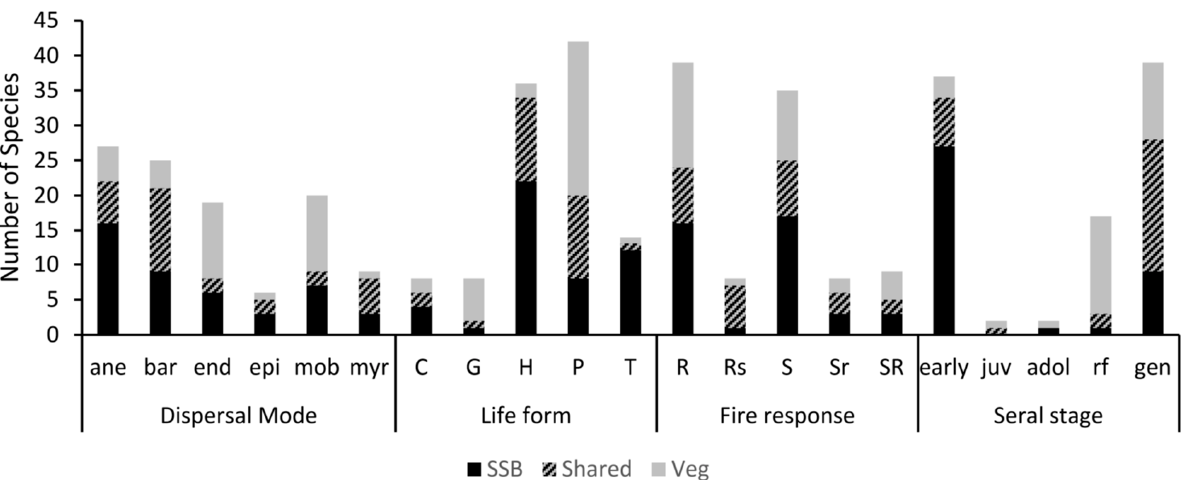
Figure 3. Frequency of plant functional types restricted to the soil seed bank (SSB) or extant vegetation (Veg), and those shared between vegetation pools. Dispersal mode: ane, anemochory; bar, barochory; end, endozoochory; epi, epizoochory; mob, mobile; myr, myrmecochory. Life form: T, therophyte; H, hemicryptophyte; C, chamaephyte; P, phanerophyte; G, geophyte. Fire response: R, obligate resprouters; Rs, weak resprouters; S, obligate seeders; SR, facultative seeders; Sr, weak seeders. Seral stage: juv, juvenile; adol, adolescent; gen, generalist; rf, rainforest. See Table 2 for definitions of functional types. Data were excluded where trait information was missing (see Table S2).